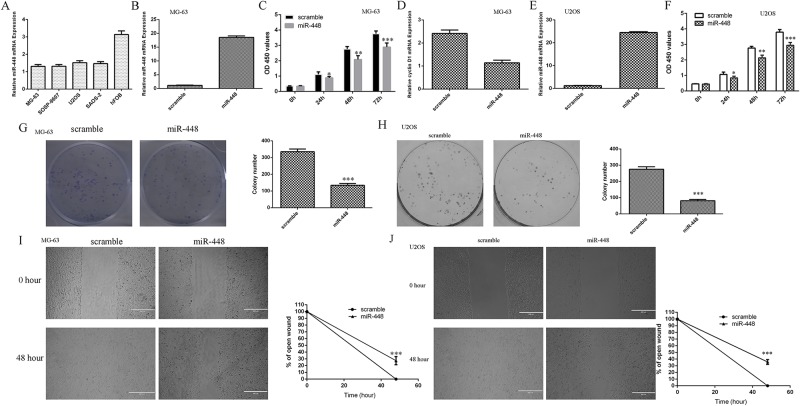
Overexpression of miR-448 suppressed osteosarcoma cell proliferation, colony formation and migration.(A) The expression level of miR-448 in osteosarcoma cell lines (U2OS, MG-63, SAOS-2 and SOSP-9607) and the osteoblast cell line (hFOB) was determined by qRT-PCR. (B) miR-448 expression was significantly upregulated in the MG-63 cells after treatment with miR-448 mimic. (C) Elevated expression of miR-448 suppressed MG-63 cell proliferation. (D) Overexpression of miR-448 also decreased cyclin D1 expression in the MG-63 cells.(E) miR-448 expression was significantly upregulated in the U2OS cells after treatment with miR-448 mimic.(F) Elevated expression of miR-448 suppressed U2OS cell proliferation.(G) Overexpression of miR-448 inhibited MG-63 cell colony formation. The relative cell colony formation is shown. (H) Overexpression of miR-448 inhibited U2OS cell colony formation. The relative cell colony formation is shown. (I) Ectopic expression of miR-448 suppressed MG-63 cell migration. The relative open wound is shown. (J)Ectopic expression of miR-448 suppressed U2OS cell migration. The relative open wound is shown.*p<0.05, **p<0.01 and ***p<0.001.